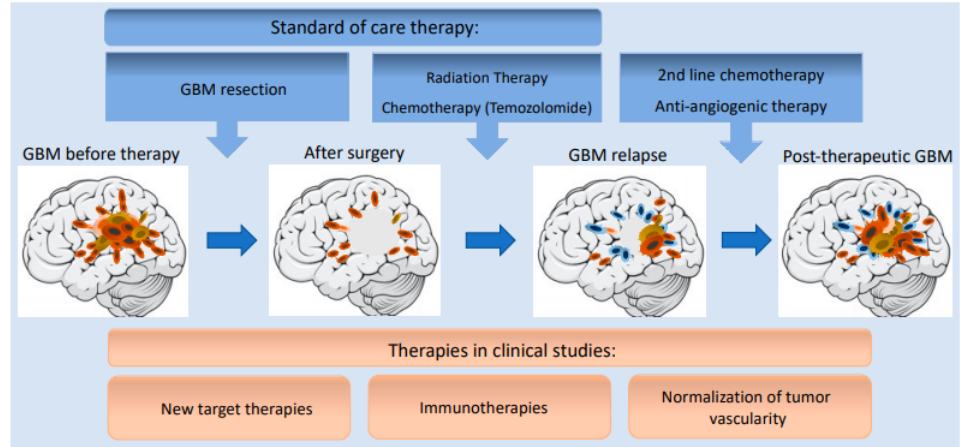
Figure 2. Progression of GBM development during standard-of-care and second line therapies. For GBM patients, standard-of-care therapy usually combines surgery followed radiation and chemotherapy with Temozolomide (TMZ). However, persistant GSCs can acquire more aggres- sive mesenchymal-like phenotype which might ultimately lead to tumor relapse. In second line treatment, there are few options including chemotherapeutic agents, such as TMZ, and platins, as well as the anti-angiogenic antibodies, Bevacizumab. Novel, promising therapeutic approaches are under development in clinical trials such as new targeted therapies, immunotherapies, and/or vascular